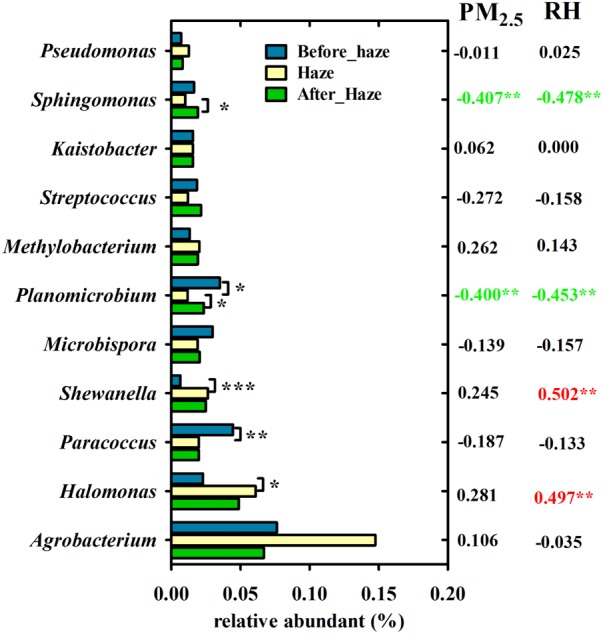
Variation in bacterial genera with ≥1% relative abundance among haze days, before and after haze pollution. Pearson’s correlation coefficients between these genera and PM2.5 index, RH is shown in the right. ∗∗∗P < 0.001, ∗∗P < 0.01, ∗P < 0.05.